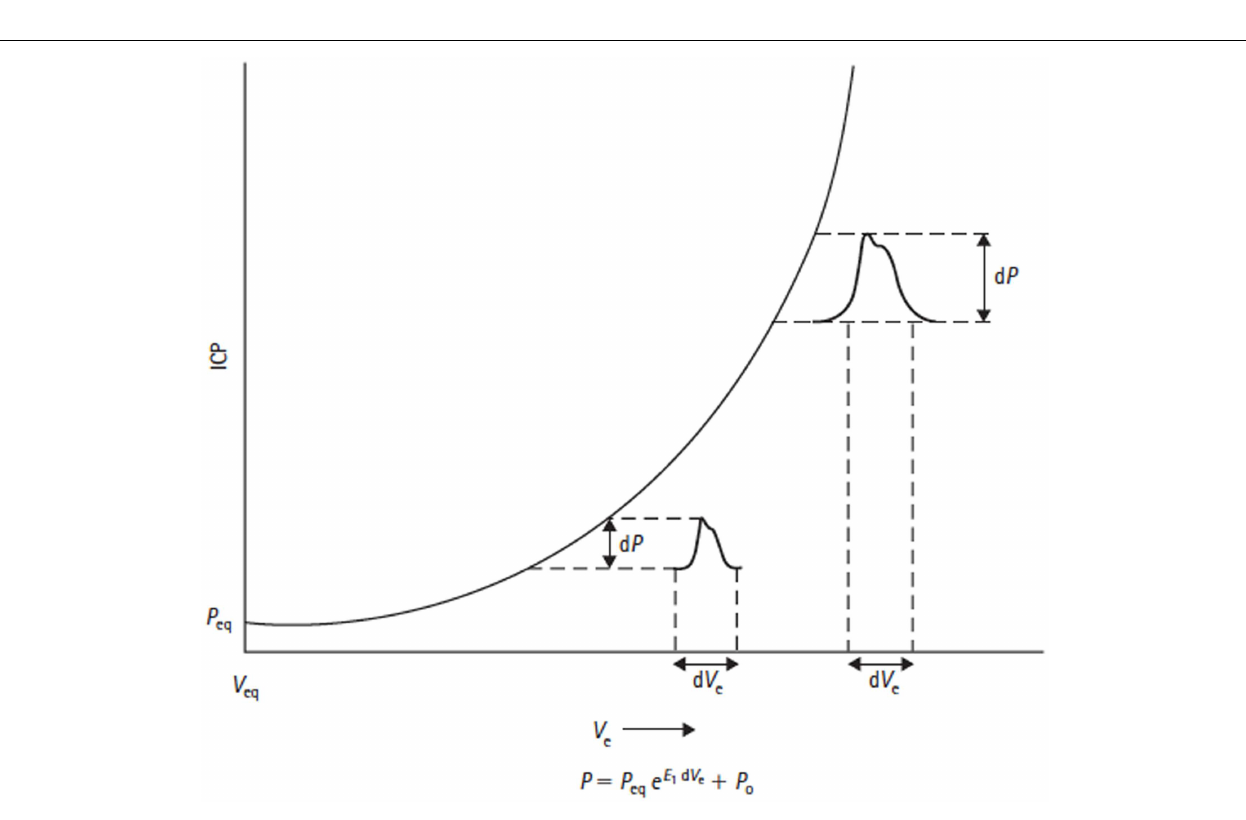
FIGURE 6 |Volume–pressure relationship and equation are shown . Adapted from Avezaat andVan Eijndhoven (31). Craniospinal volume–pressure relationship demonstrating that for the same increase in craniospinal volume (d V e ) the ICP pulse amplitude (d P ) increases when total craniospinal volume